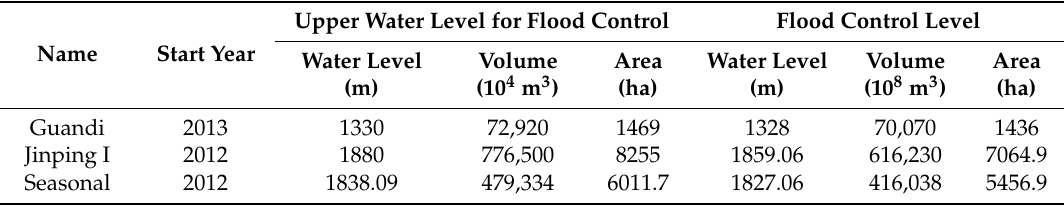
Table 2. Information on the reservoirs used for this